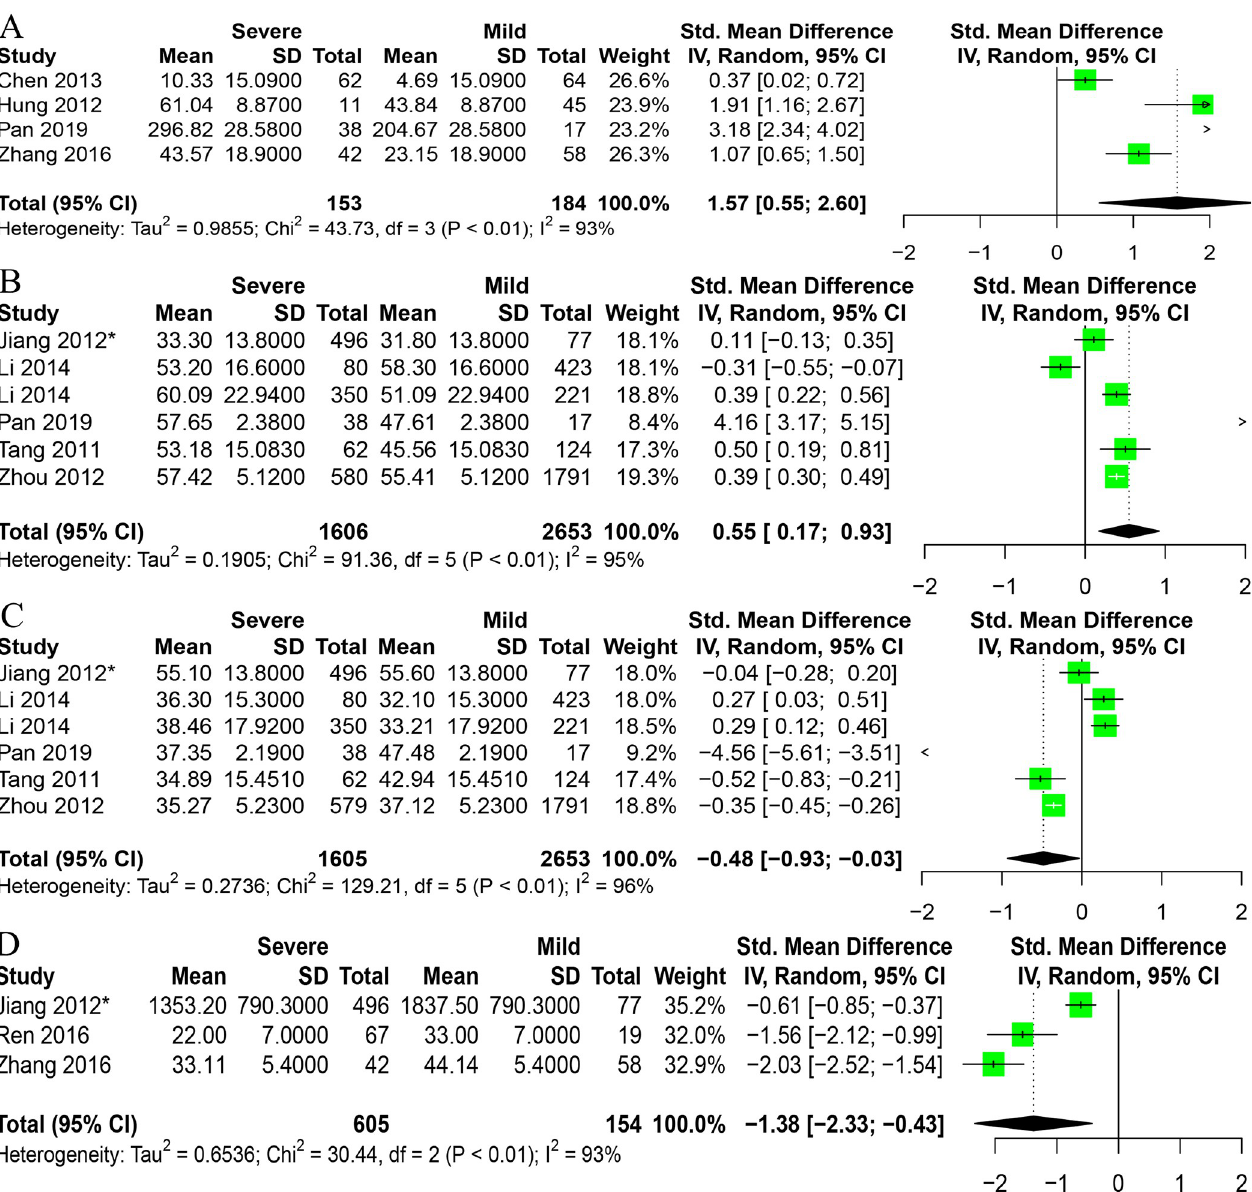
Fig 3. Forest plots of meta-analysis on a panel of routine laboratory parameters. A IL-6, B Neutrophils, C Lymphocytes, D CD4+. � Data is converted from the original data. https://doi.org/10.1371/journal.pone.0267716.g003 results displayed reduced CD4 + levels (SMD = -1.38, 95%CI: -2.33 to -0.43), lymphocytes ratio (SMD = -0.48, 95%CI: -0.93 to -0.33) and WBC count (SMD = -0.68, 95%CI: -1.33 to -0.04). However, there was no significant association with IL-10 and CRP (SMD = 0.33, 95%CI: -0.96, 1.62) levels in patients with severe cases of HFMD compared with patients with mild cases. Risk factors for HFMD For the risk of death from HFMD, we analyzed sex, age, cyanosis, fast heart rate, vomiting, duration of fever � 3 days, and WBC count. Cyanosis (OR = 5.82, 95% CI: 2.29 to 14.81), fast